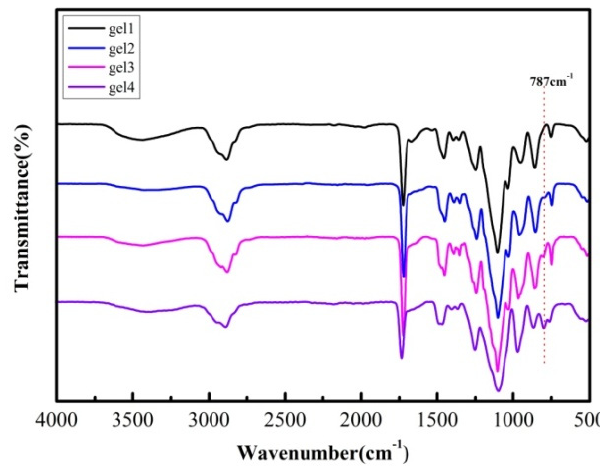
Figure 3. The FT − IR spectra of gel 1, gel2, gel 3, and gel 4.